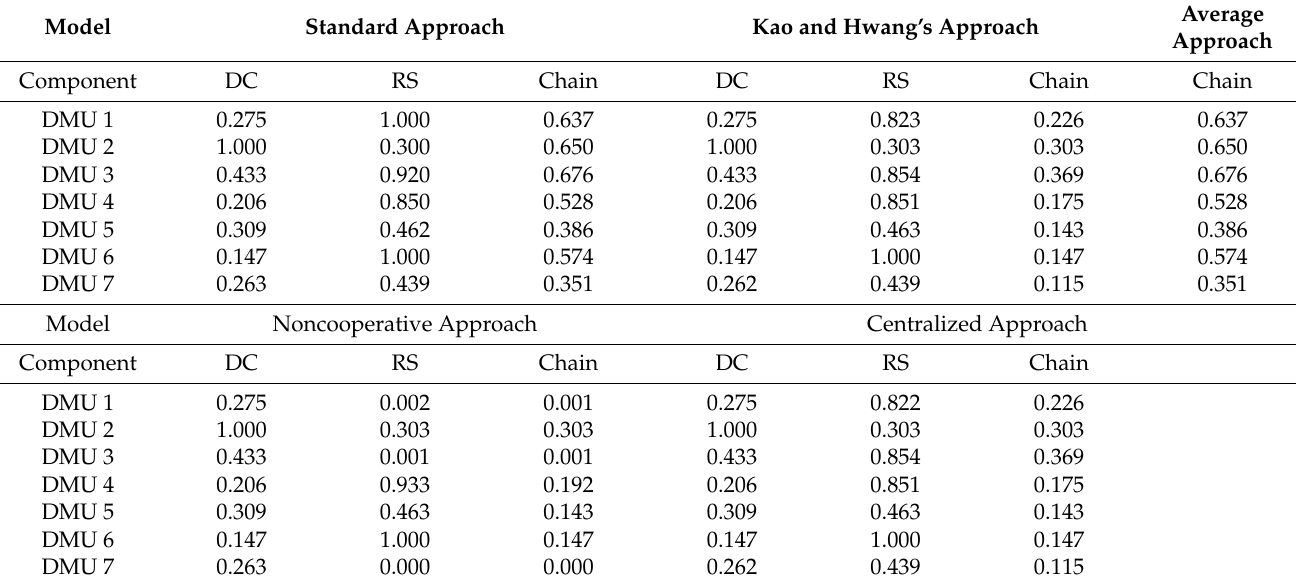
Table 3. Efficiency scores form different